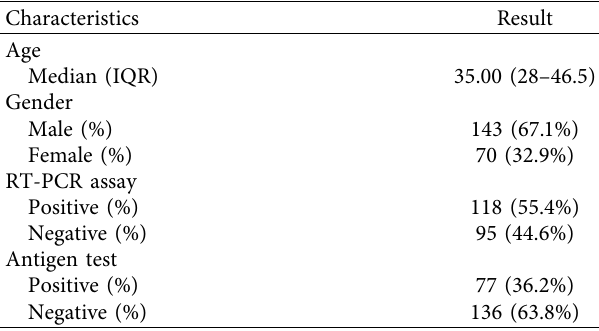
Table 1: Characteristics of study population.